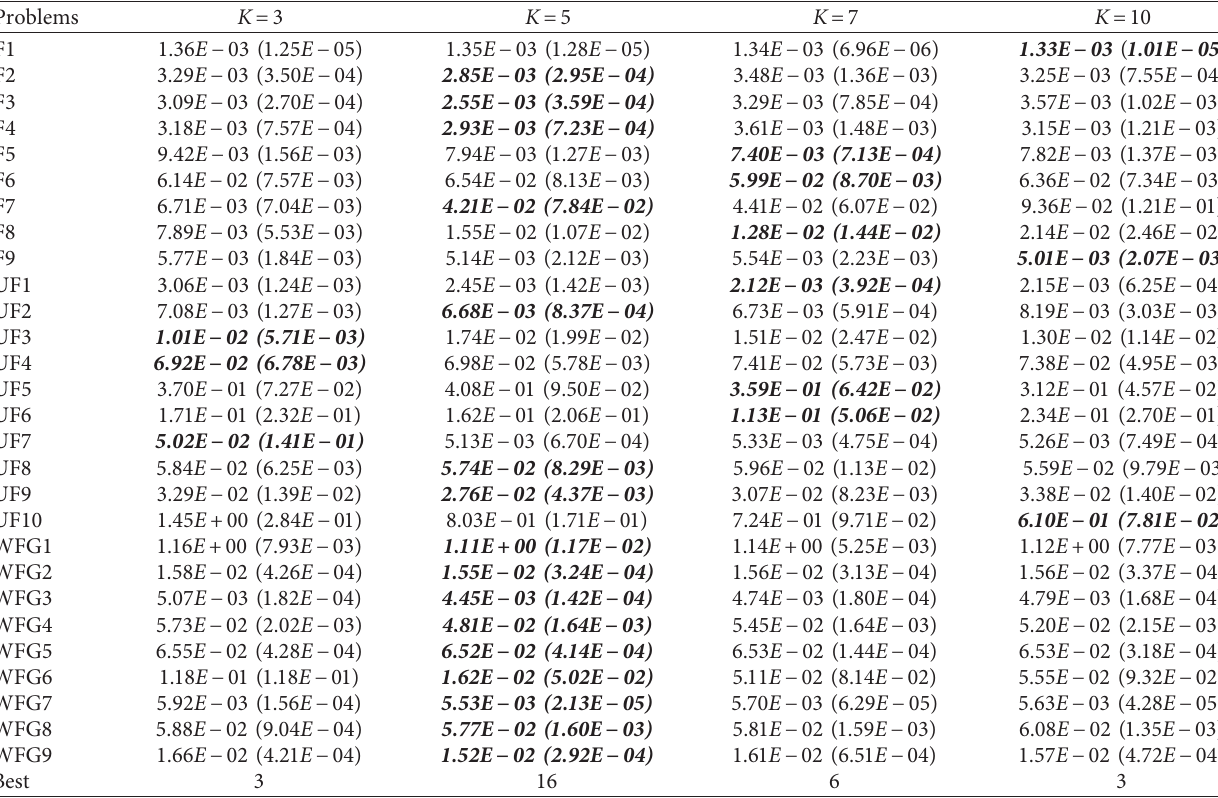
Table 7: Performance comparison of MOEA/D-AMG with different values of K in terms of the average IGD values and standard deviations on F, UF, and WFG